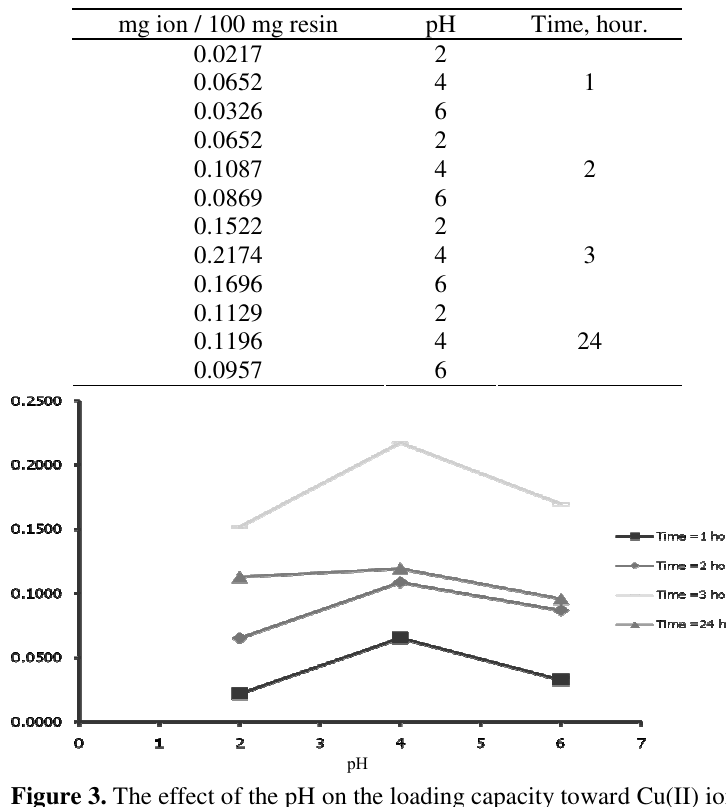
Table 3. The effect of pH on the loading capacity for Cu(II) ions.